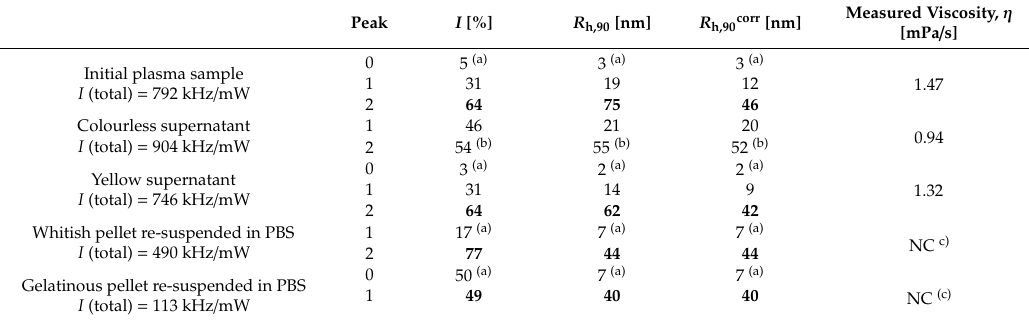
Measured Viscosity, η [mPa / s] 0.94 2 NC c) 2 77 44 44 NC (c) 1 49 40